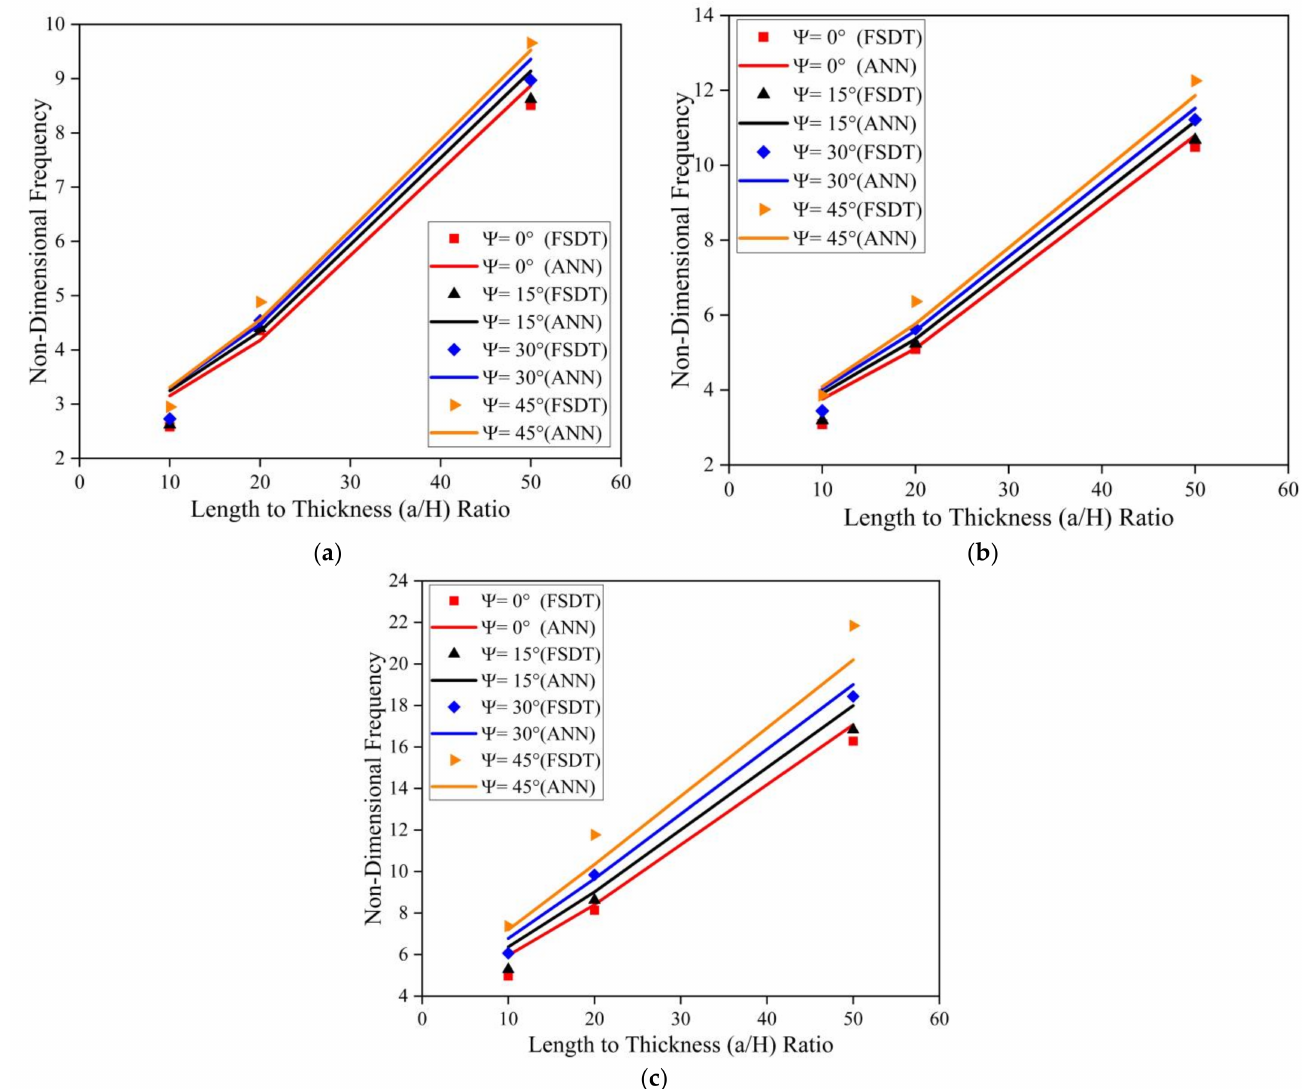
Figure 10. Influence of skew angle on the simply supported skew LCS plate operating at elevated thermal environment (325 K) for varying a/b and a/H ratios ( a ) a/b = 0.5 ( b ) a/b = 1.0 ( c ) a/b =